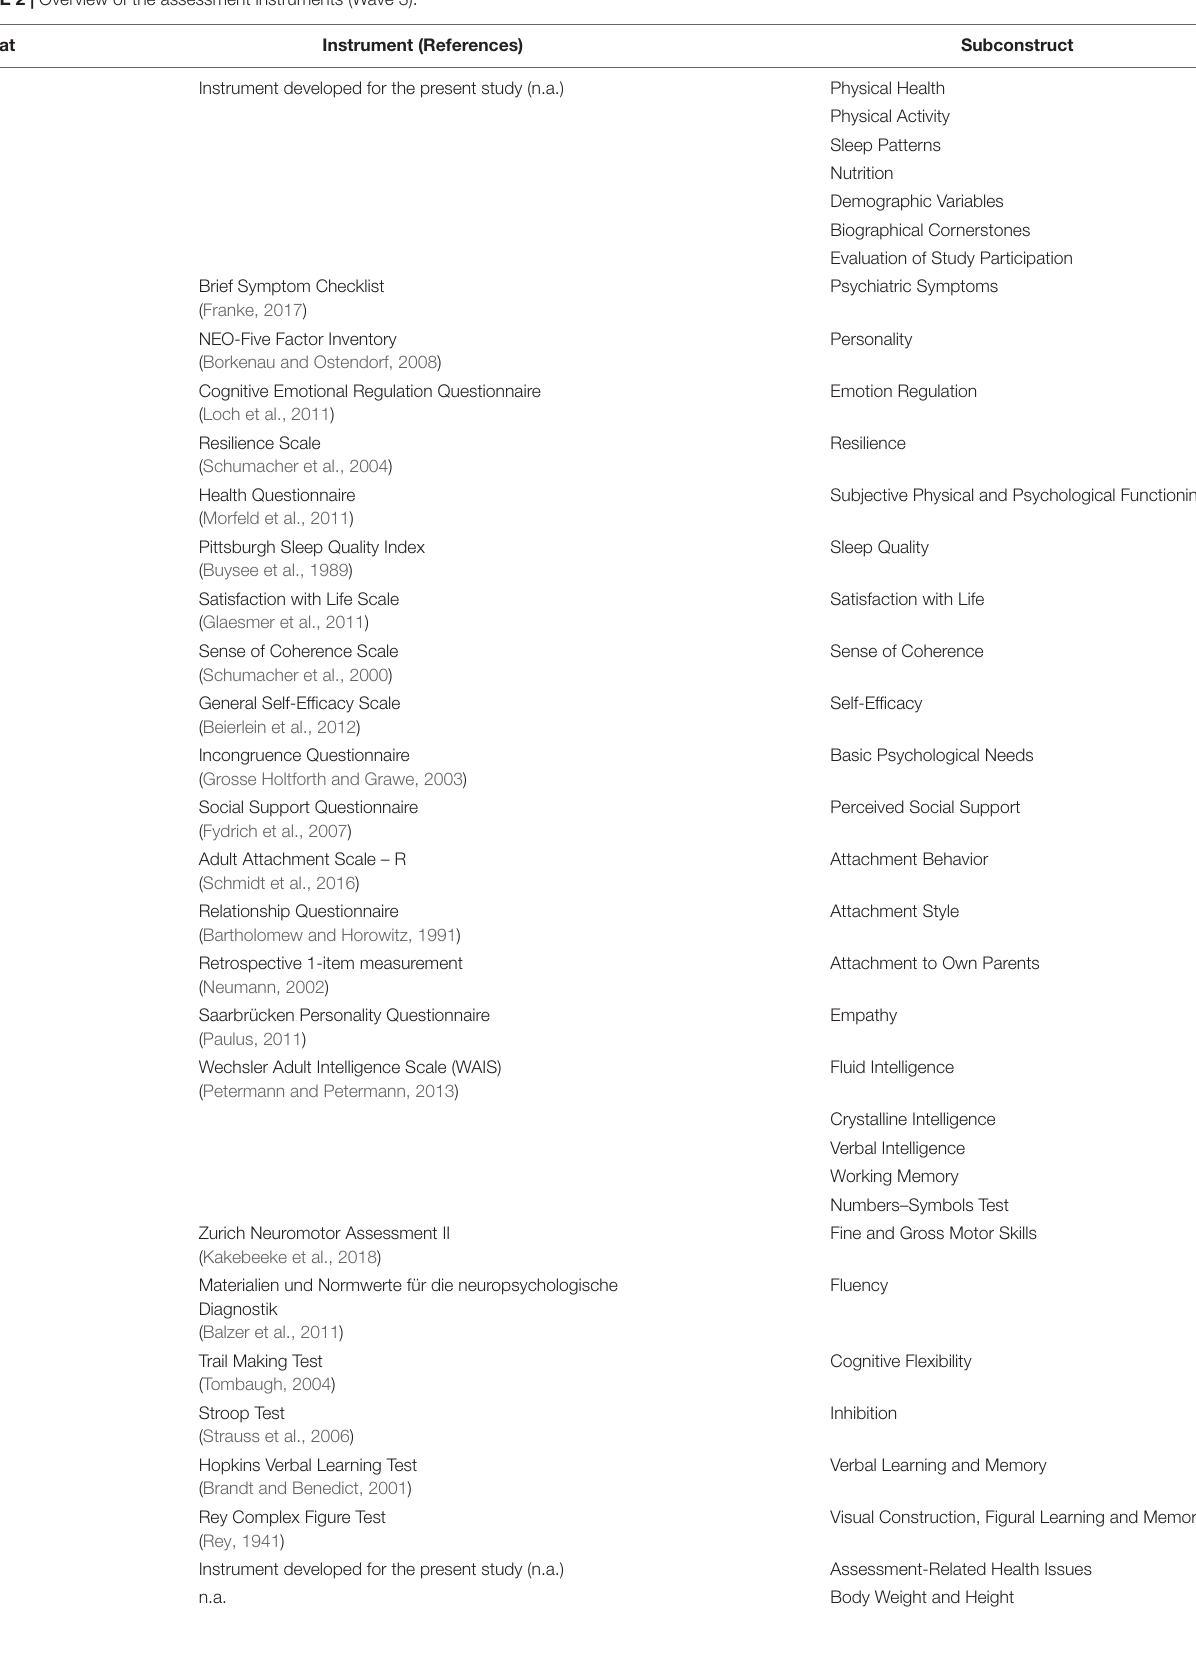
TABLE 2 | Overview of the assessment instruments (Wave